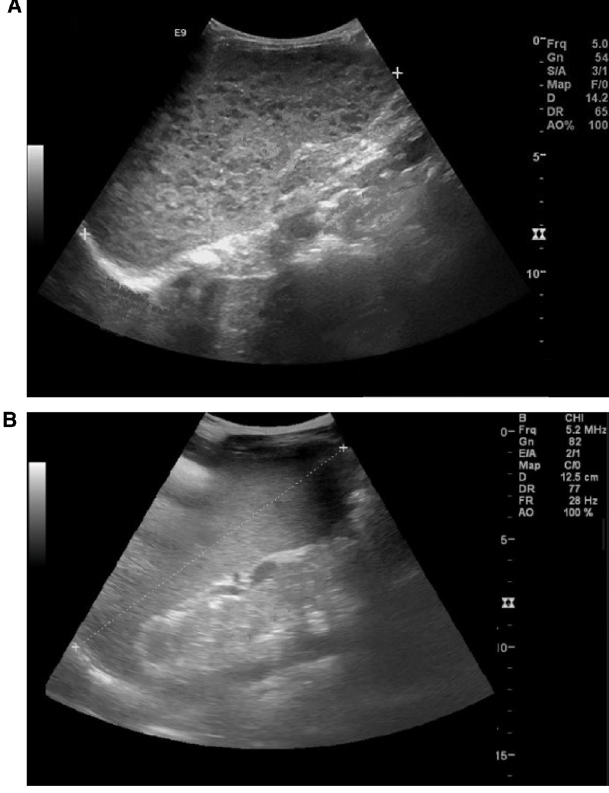
Figure 1. Ultrasound scan of enlarged spleen in ( A ) Case 1 and ( B ) Case